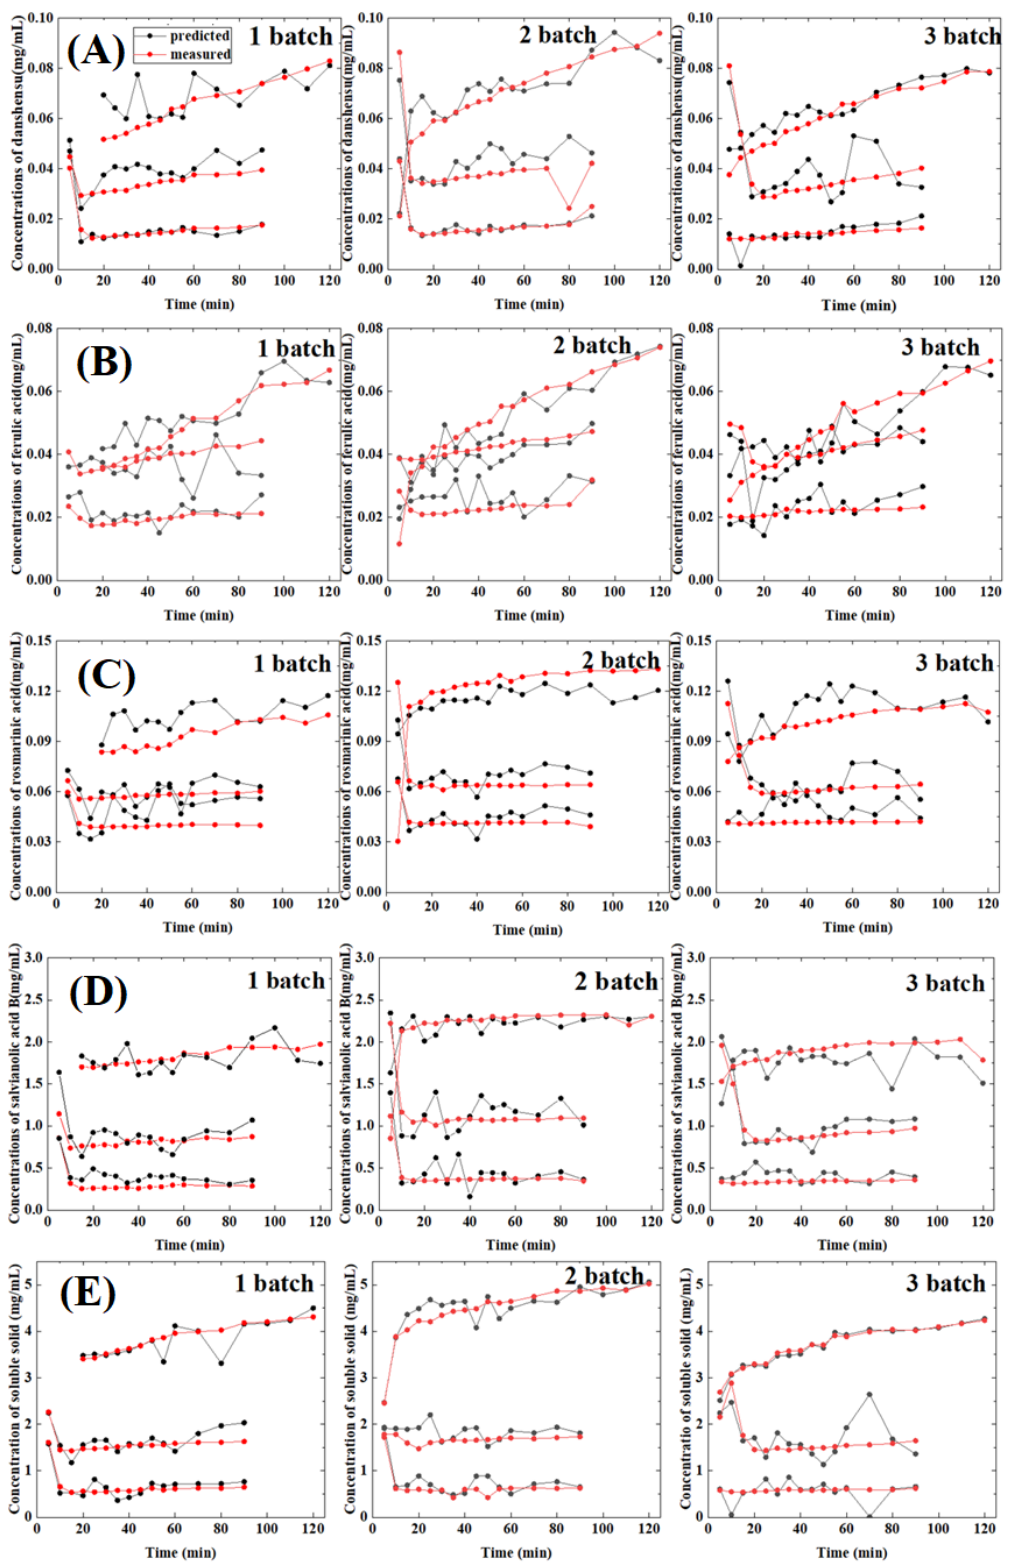
Figure 7. Contents of the five key attributes of three batches of unknown samples predicted with the established CARS-CNN model: ( A ) danshensu, ( B ) ferulic acid, ( C ) rosmarinic acid, ( D ) salvianolic acid B, and ( E ) soluble